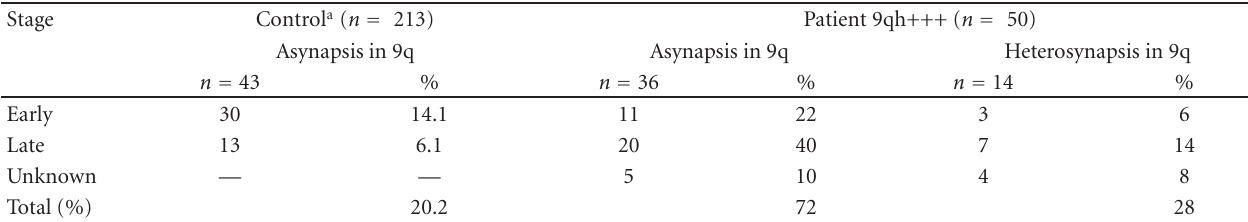
Table 3: Number and percentage of asynapsis and heterosynapsis found according to the di ff erent pachytene stages analyzed for bivalent 9.